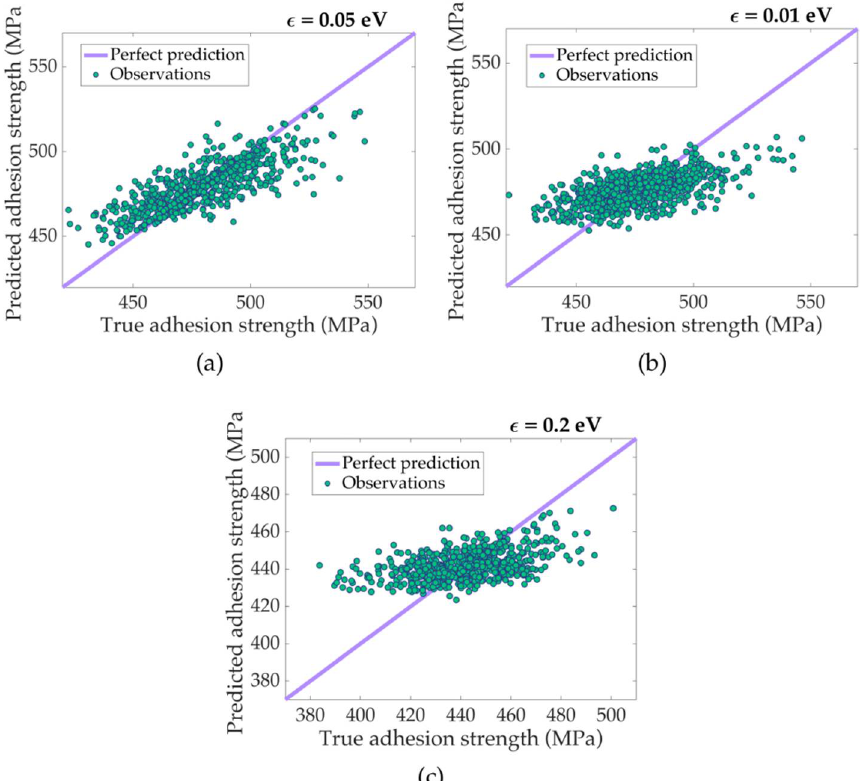
Figure 5. Comparison of the ice adhesion strength on rough surfaces obtained by MD simulations and by SVM prediction. The results for surfaces with epsilon values ( (cid:101) ) of 0.05, 0.1, and 0.2 eV are shown in ( a – c ), respectively. The ice adhesion strength obtained by the MD simulation is given as solid green circle (observations), while the prediction strength of the SVM is given in light purple solid lines (perfect prediction). A perfect prediction would have all the green data points on the purple line.